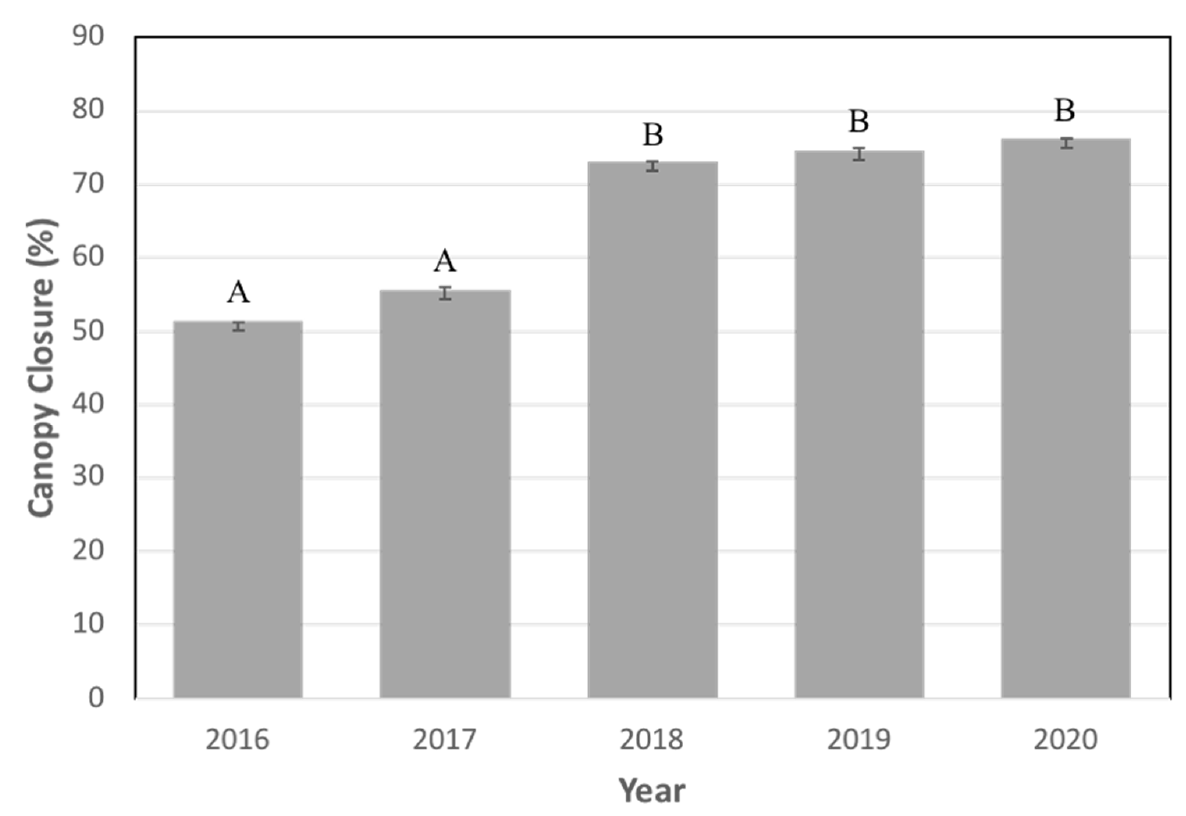
Figure 6. Percent canopy closure for 2016–2020. Bars that share letters are not statistically different according to Bonferroni-adjusted mean comparison.